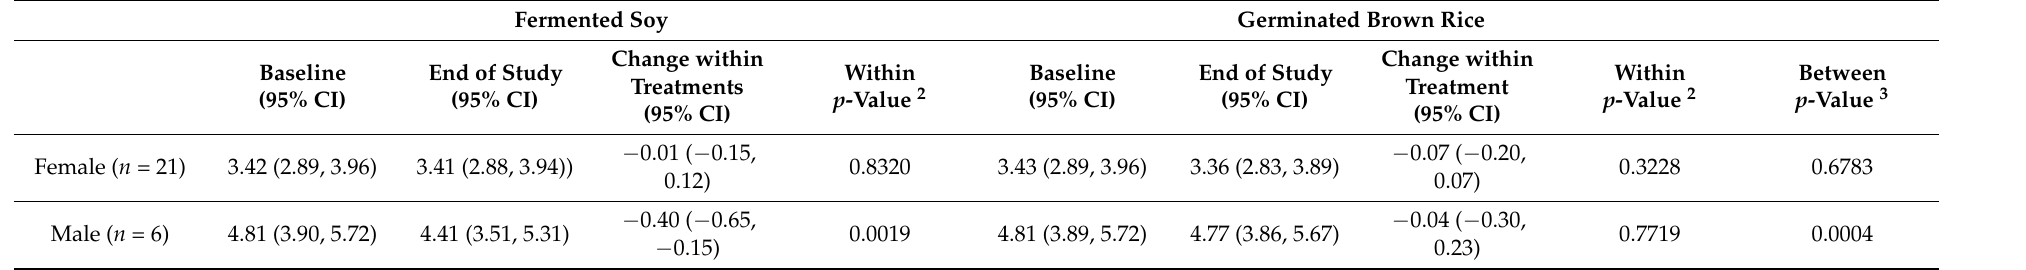
Table 4. Effect modification by sex on the total cholesterol:HDL cholesterol ratio 1